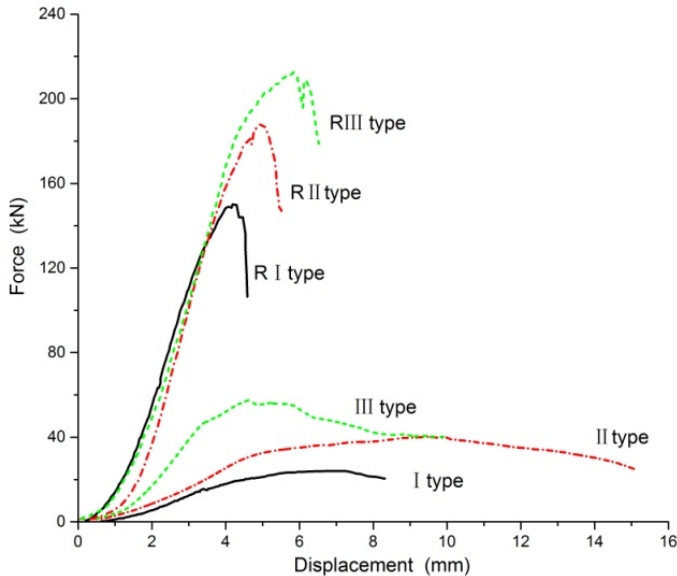
Figure 6. Force–displacement curve of a wood lattice sandwich structure specimen .